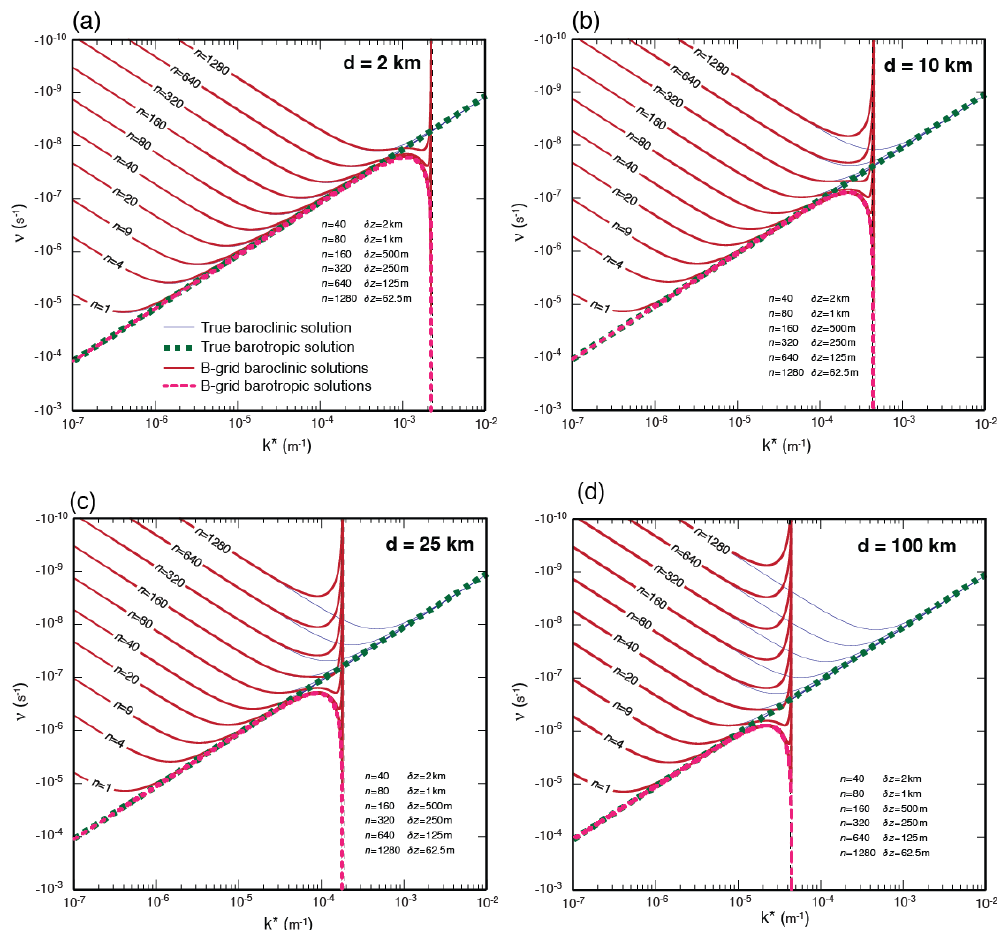
Figure 6. Same as Fig. 1 but on the B